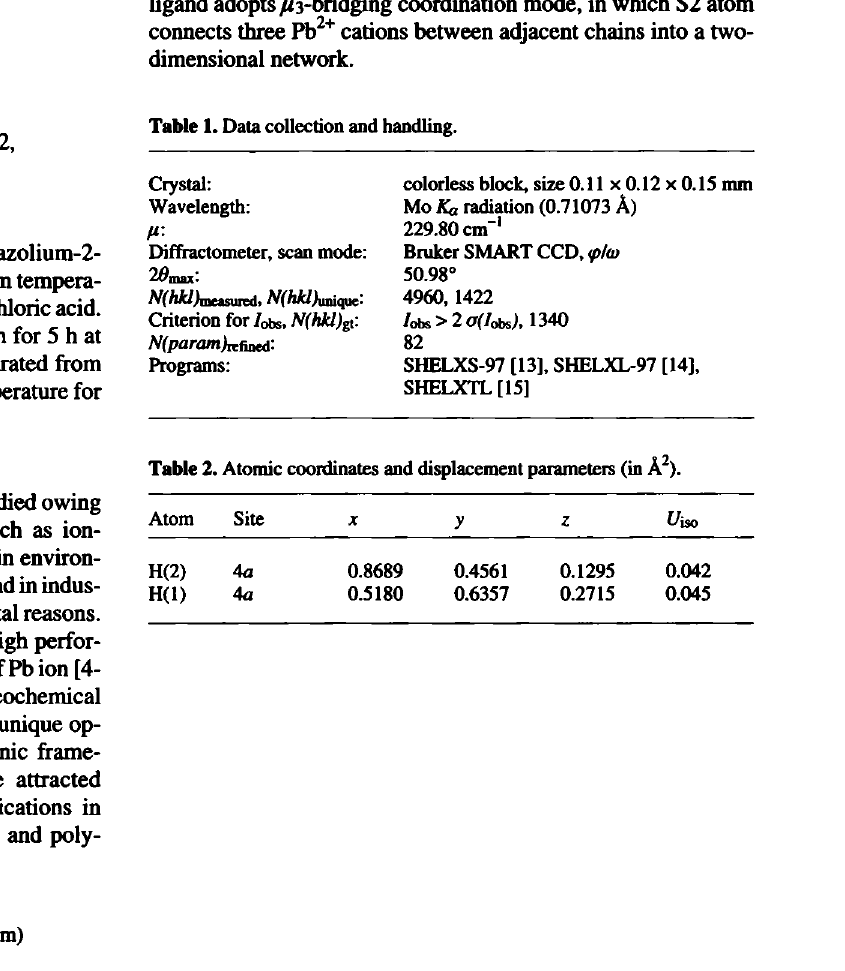
ligand (figure, top). The l,3,4-thiadiazolium-2-thiolate adopts a zwitterionic form. Each Pb atom is eight-coordinated by three S atoms from three l,3,4-thiadiazolium-2-thiolate ligands and five CI" ions. The Pb-Cl and Pb-S bond lengths are d(Pb—Cll) = 2.925(2) Â, d( Pb—C12) = 2.902(2) Â, d(Pb—Cll A) = 2.894<2) Â), </(Pb—C12A) = 2.871(2) Â, d( Pb—C12B) = 2.954(2) Â, ¿(Pb—S2) = 3.254(2) Â, d(Pb —S2A) = 3.437(2) Â and d(Pb—S2B) = 3.310(2) Â, respectively, being in the normal range observed for other complexes containing S or CI donors [11,12]. The CP ion shows /^-bridging (Cll) and ^-bridging (C12) coordination mode, and link the Pb 2 * cations into an one- dimensional network, with the Pb—Pb distance of 4.6099(7) Â and 4.1116(8) Â, respectively. The Pb—Pb distance between ad- jacent chains is 5.7597(8) Â. The l,3,4-thiadiazolium-2-thiolate ligand adopts /^-bridging coordination mode, in which S2 atom